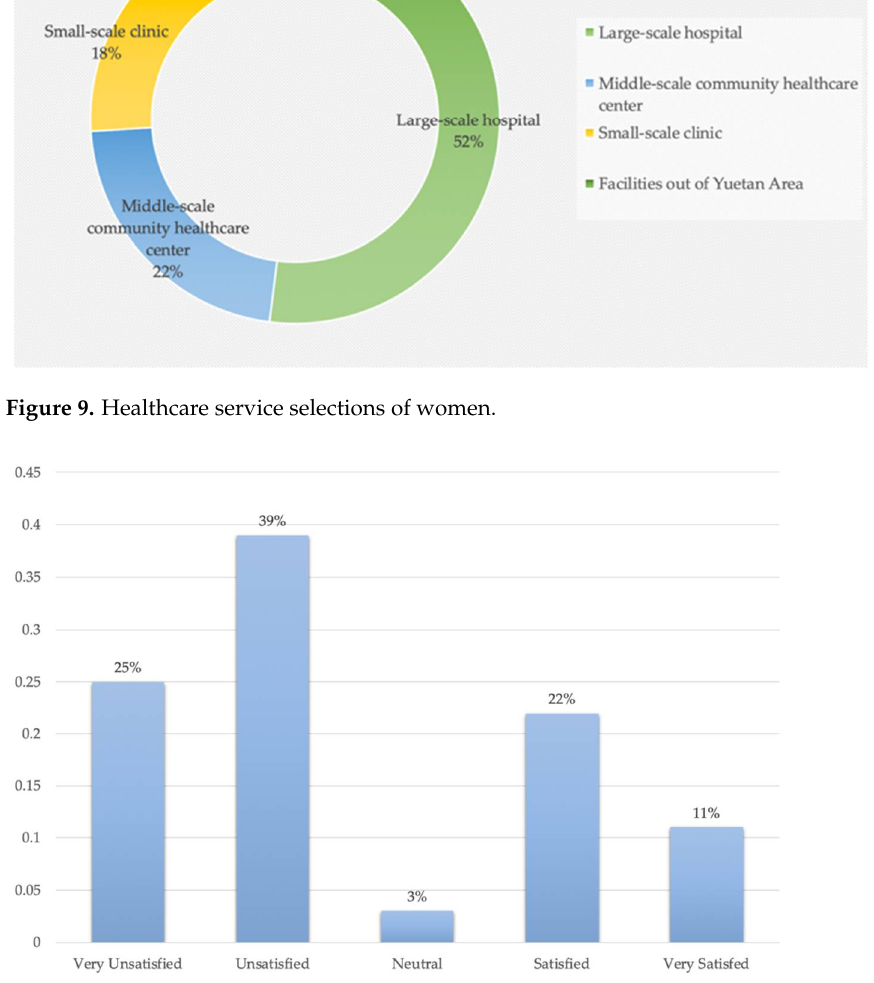
Figure 10. Women’s satisfaction with healthcare facilities.